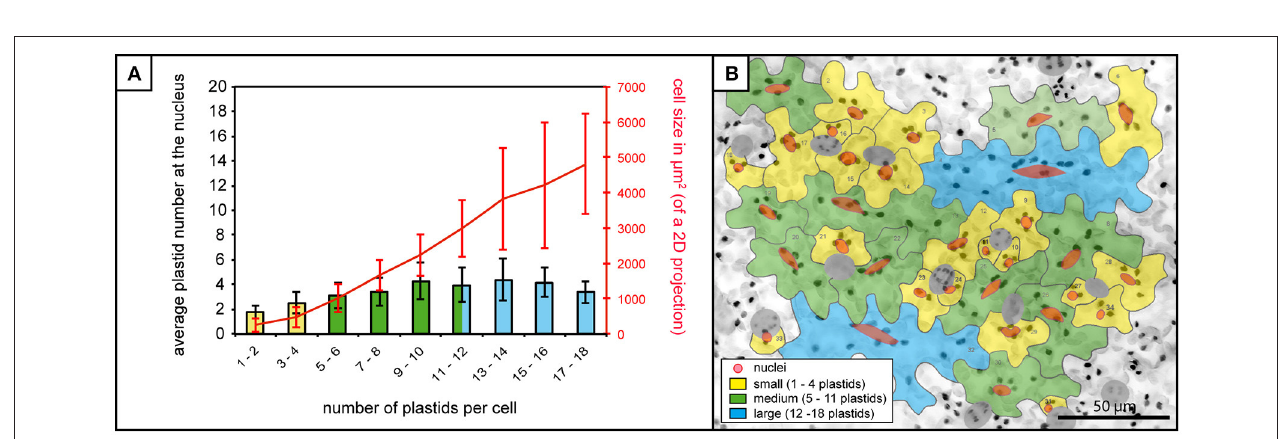
FIGURE 2 | Plastid-nucleus association in A. thaliana rosette leaf upper epidermis. (A) Bars represent the average number of plastids at the nucleus in cells of increasing plastid number (x-axis), while the red line represents accompanying increases in average cell size. Bars colors match cell size categories, small (yellow), medium (green) and large (blue) cells as shown in (B) . Error bars represent standard deviation. (B) Z-stack of A. thaliana upper epidermis expressing FNRtp:eGFP (the same image as in Figure 1D ) with cells numbered and outlined in gray, nuclei in red (stomatal guard cells excluded from the analysis, in dark gray). Cells in the three different size categories colored in yellow (small cells), green (medium cells) and blue (large cells). Scale = 50 µ